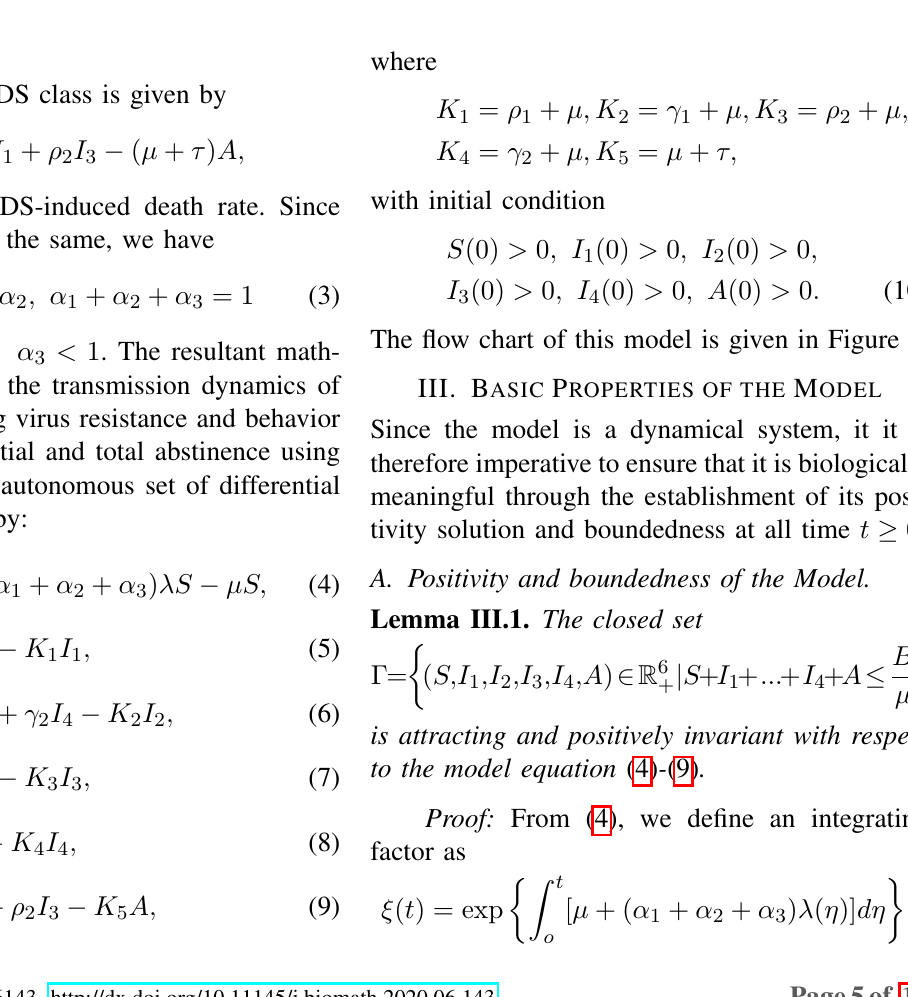
Fig. 1. Flow chart of the